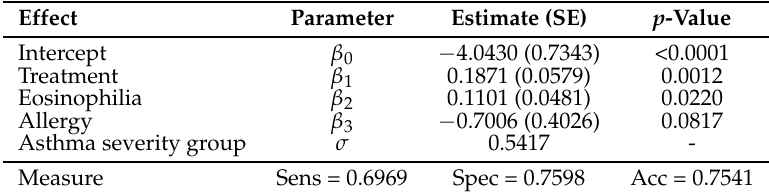
Table 1. Estimates (with SE in parentheses), p -values, and Sens, Spec and Acc measures for asthma